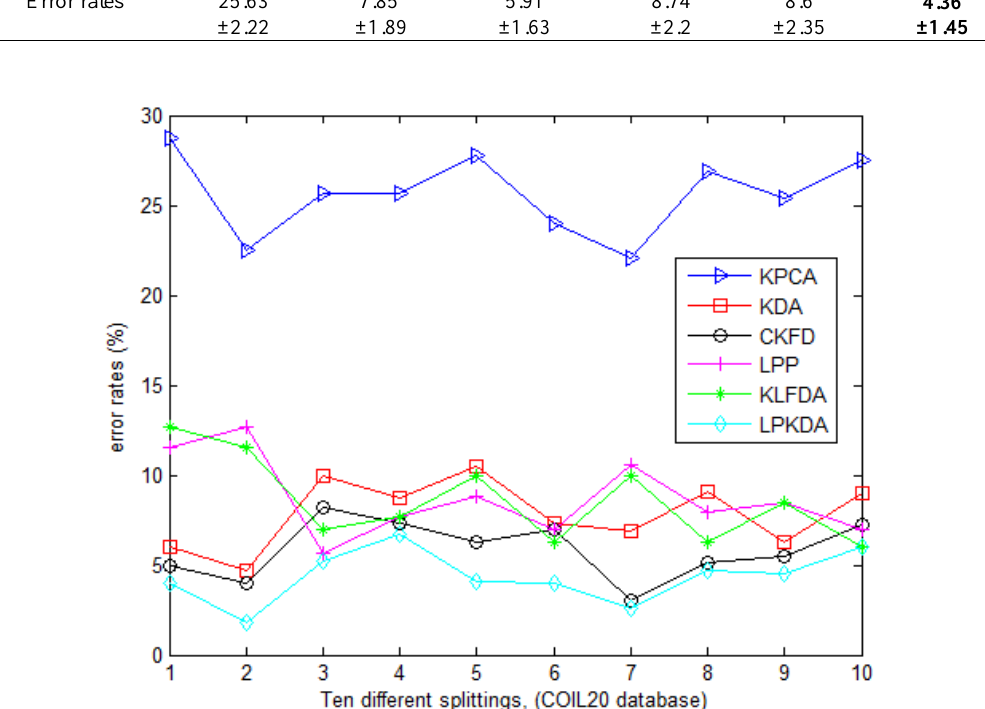
Fig.4. Comparison of KPCA, KDA, CKFD, LPP, KLFDA , and LPKDA in error rates on COIL20